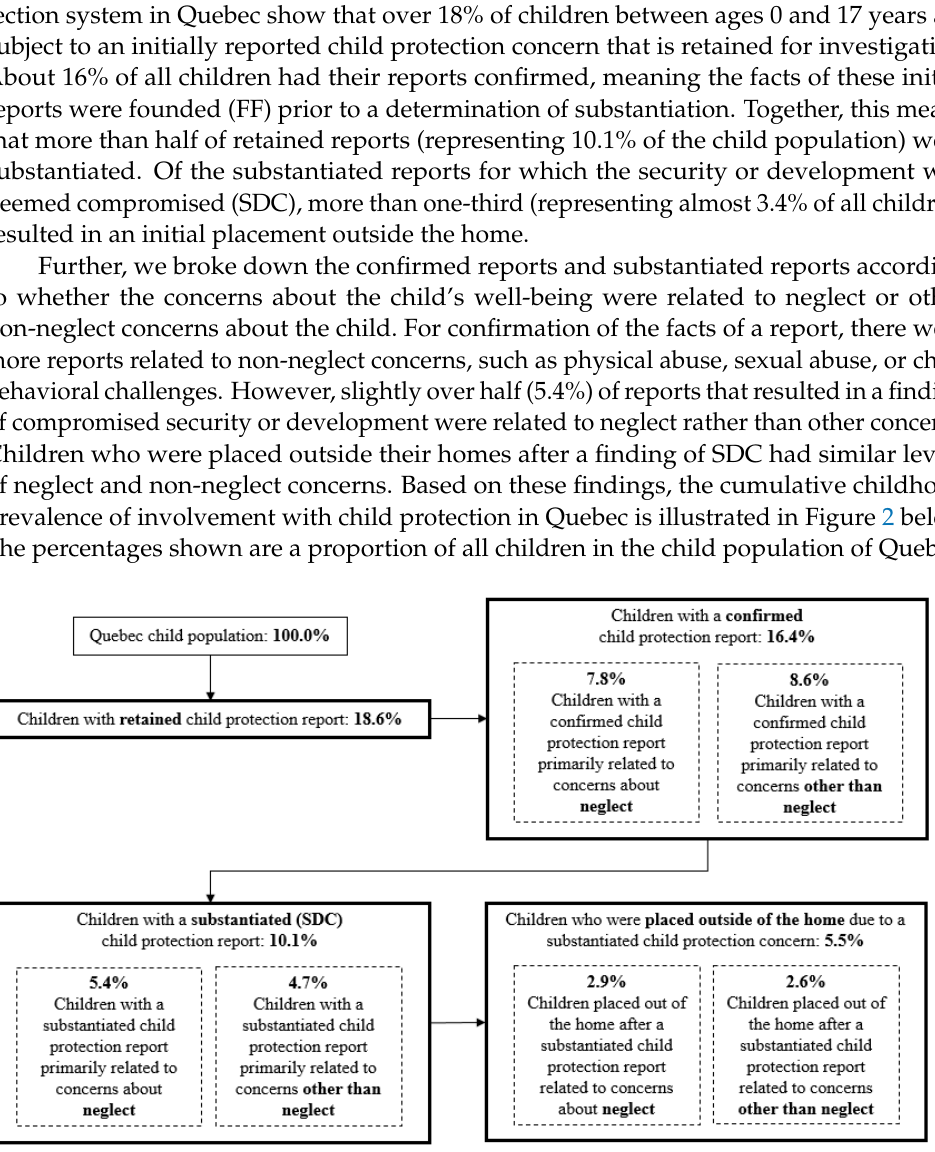
Figure 2. Survival table estimates of childhood prevalence of involvement in Quebec child protection system (as percentage of entire child population).